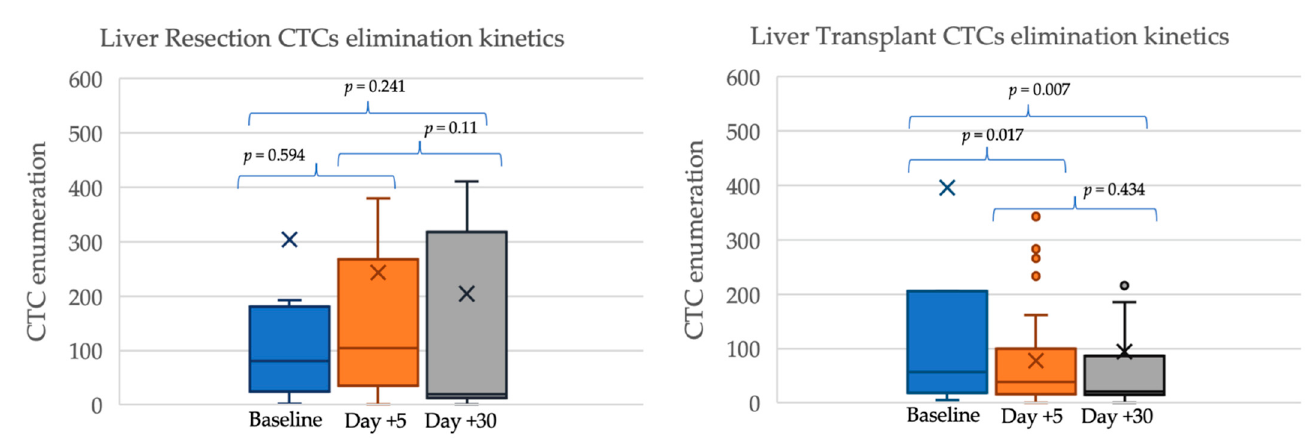
Figure 1. CTCs enumeration in patients with hepatocellular carcinoma undergoing LR ( n = 10) or LT ( n = 31). Table 2. CTC clusters and total enumeration. Median and interquartile range are presented.